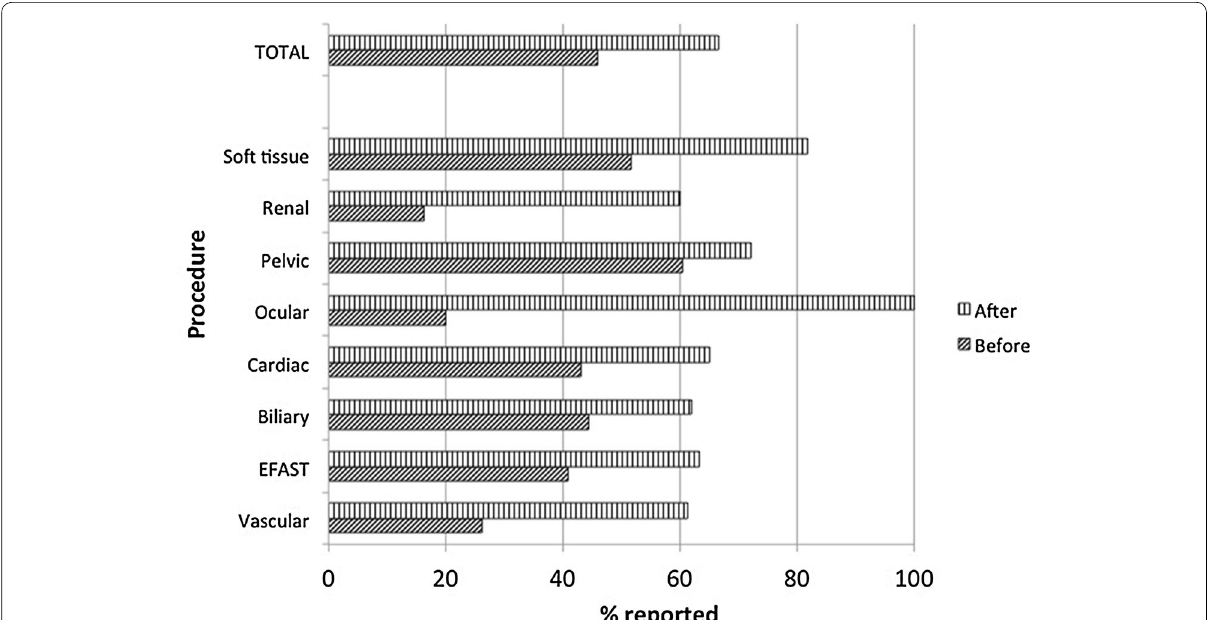
Fig. 1 The percentage of scans reported to the medical coders in the pre- and post-intervention periods. X-axis represents the percentage of POC u/s scans documented and reported for coding ( slanted dark hashed bar pre-intervention data; vertical hashed bar post-intervention data). Y-axis identifies the number of application specific and number of total POC u/s